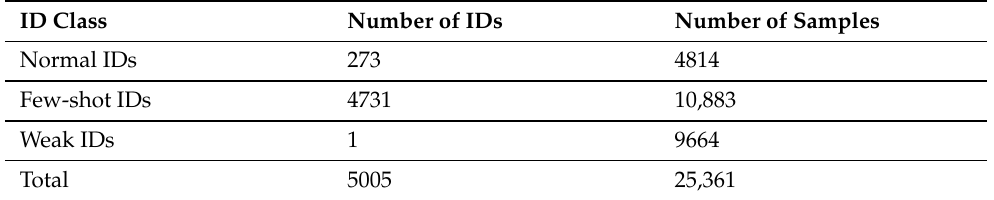
Table 1. Details of the training dataset provided by the competition; it can be seen that most of the samples are few-shot IDs and weak